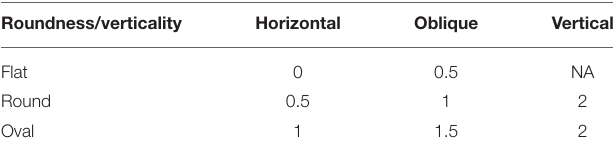
Frontiers in Neuroanatomy |